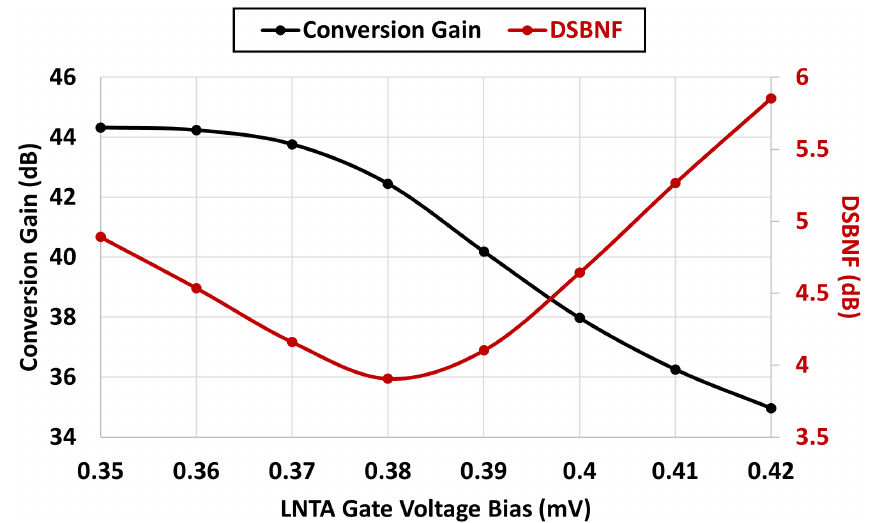
Figure 8. The NF and conversion gain versus the gate bias voltage of the